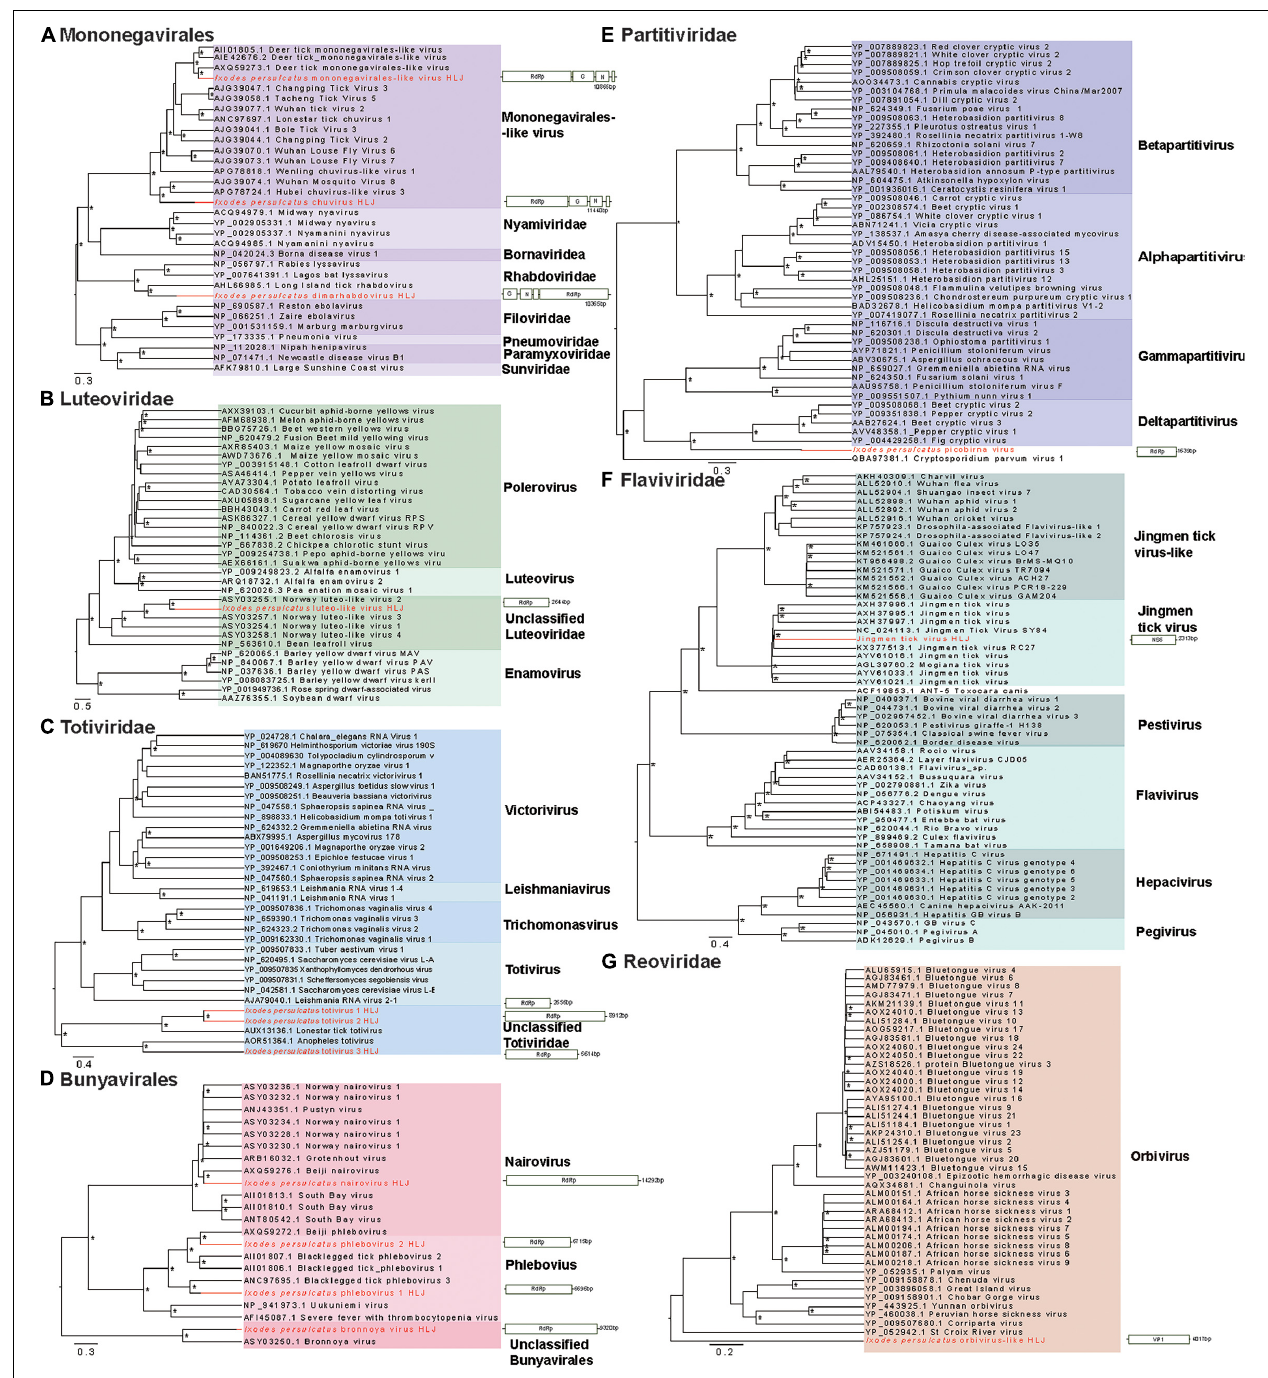
FIGURE 3 | Phylogenetic trees of the RNA-dependent RNA polymerase (RdRp) gene-based on representative amino acid sequences and schematic genome structures of 14 viruses detected in I. persulcatus ticks removed from human patients at Mudanjiang Forestry Central Hospital in Heilongjiang Province, China. (A) Mononegavirales ; (B) Luteoviridae ; (C) Totiviridae ; (D) Bunyavirales ; (E) Partitiviridae ; (F) Flaviviridae ; and (G) Reoviridae . Support values above 0.7 are indicated by asterisk. The trees were mid-point rooted.